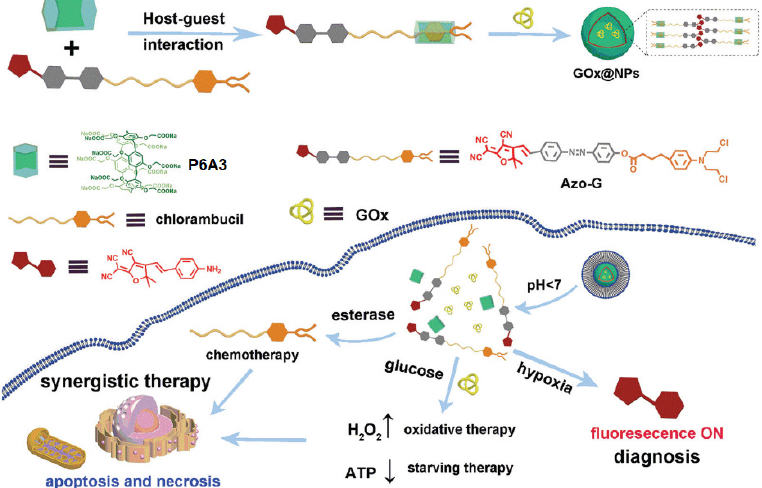
Figure 10. Fabrication of the hypoxia-activatable P6A3 -based drug delivery system. Reproduced with the permission of reference [43]. Copyright © Royal Society of Chemistry 2022.